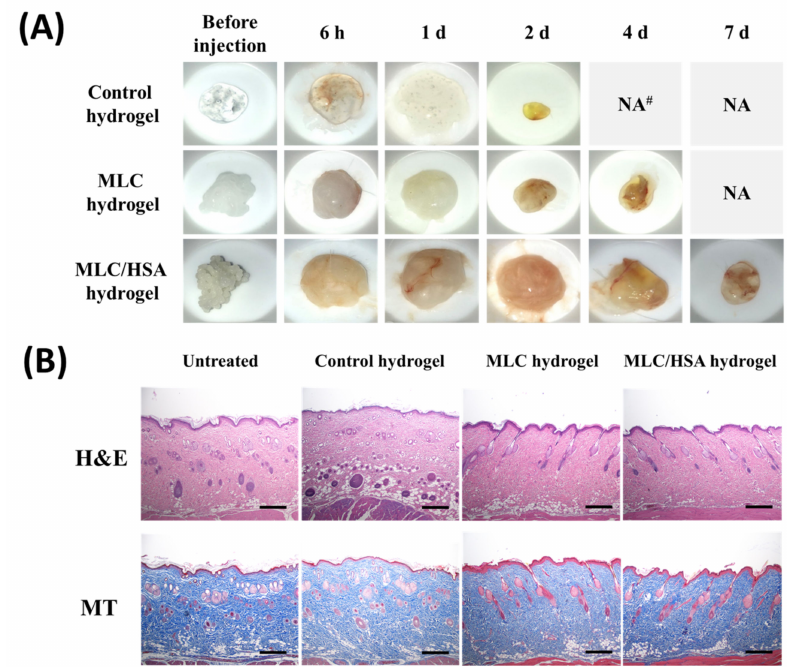
Figure 7. ( A ) Optical images of hydrogels after subcutaneous injection in rats. ( B ) Histology of the skin seven days after hydrogel injection. The untreated group indicates the skin without any treatment. Each group was stained with hematoxylin and eosin (H&E) or Masson’s trichrome (MT). The length of the scale bar is 400 µ